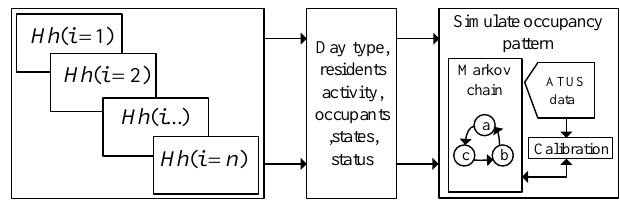
Figure 2. Flow diagram of household load